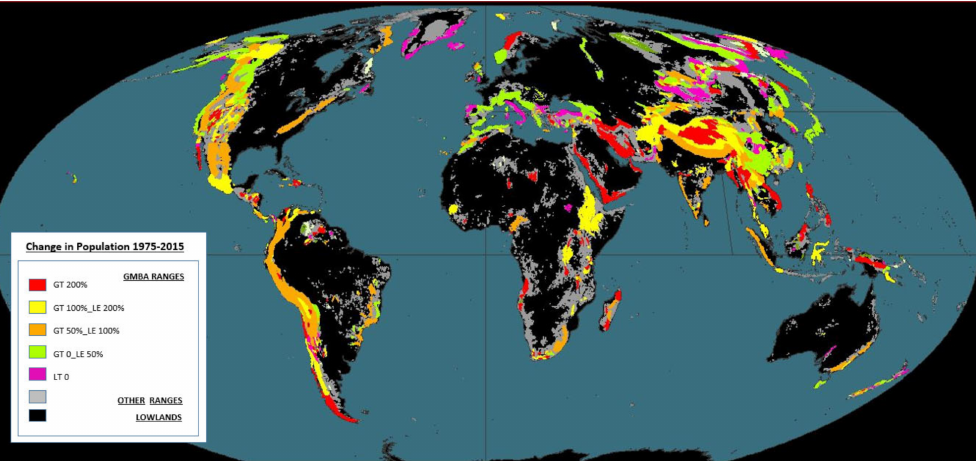
Figure 4. GMBA ranges grouped based on percent population change over 1975–2015 timeframe. The population growth rate uses 1975 as a reference year. Class 1 (Ch_C1) groups ranges growing in population more than 200%; Class 2 (Ch_C2) groups ranges growing between 100% and 200%, Class 3 (Ch_C3) ranges with growing between 50 and 100%; Class 4 (Ch_C4) ranges growing between 0 and 50%, and Class 5 (Ch_C5) ranges that decrease in